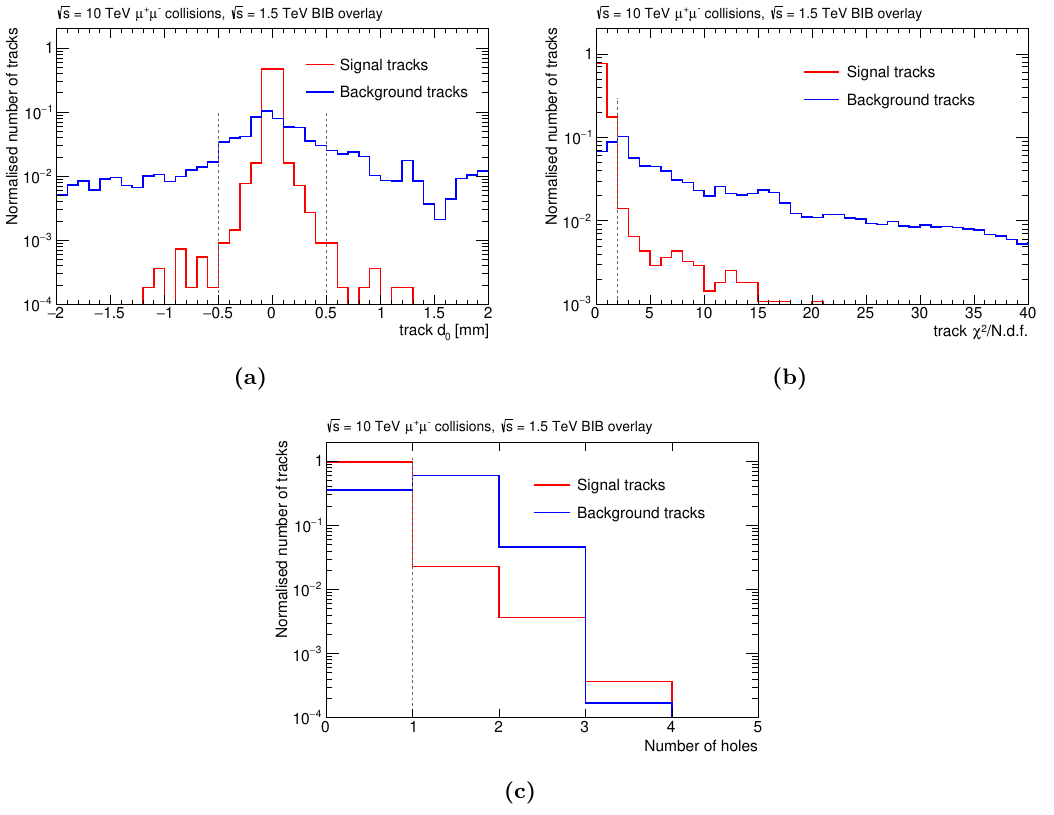
Figure 9. Distributions of the track transverse impact parameter d 0 (a), the track fit quality χ 2 / N.d.f (b), and number of holes (c). Signal tracks are presented in red, while background tracks originating from the BIB in blue. The histograms are normalised to unit area. The dashed grey lines represent the track selections applied to the track candidates. The signal track distributions are taken from a wino signal sample with m (˜ χ ± ) = 500 GeV. A track is considered as signal if the hits matched to the generator-level ˜ χ ± compose more than 70% of the total hits associated to the track. Background tracks are composed exclusively by hits from the